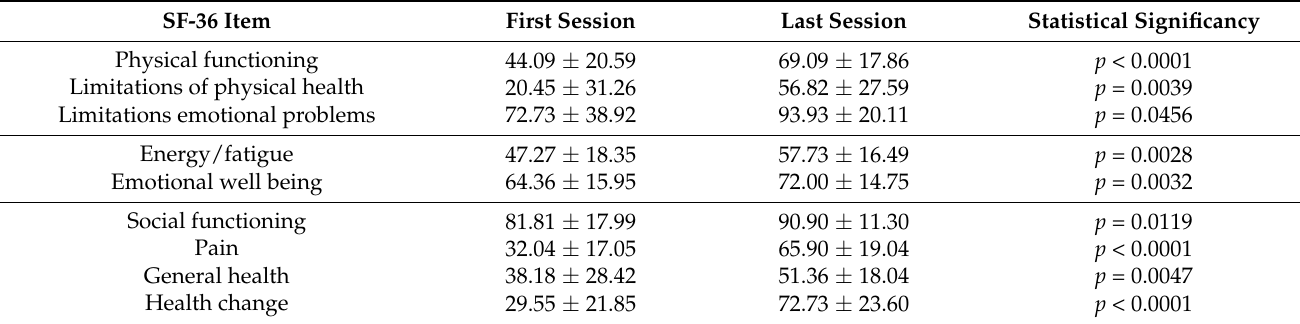
Table 4. Ketoprofen SF-36 questionnaire